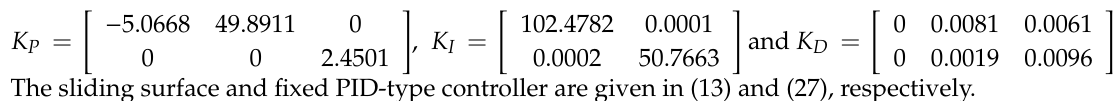
Figure 2. Time responses of the closed-loop system with the fixed PID controller and unknown perturbation.